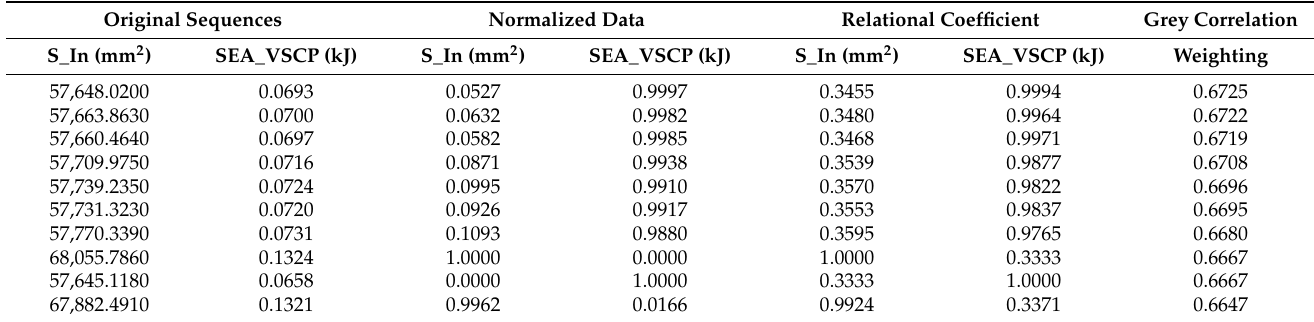
Table 7. Grey correlation analytical data (top ten).